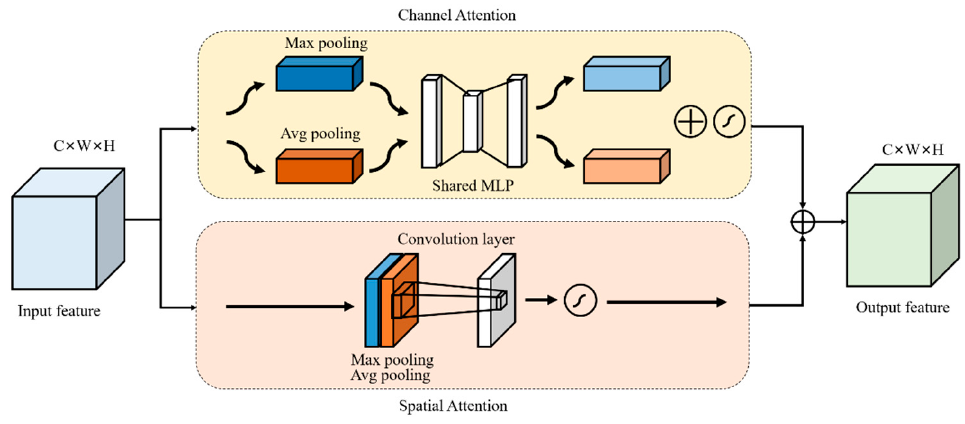
Figure 3. Structure of